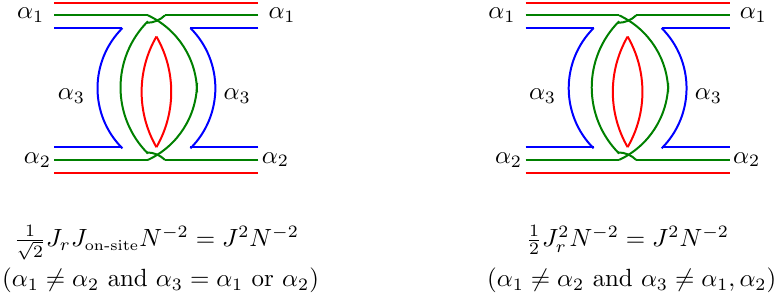
Figure 7. Contribution of interactions to dipoles of red color. For (cid:11) 1 = (cid:11) 3 6 = (cid:11) 2 = (cid:11) 4 , there are two con(cid:12)gurations that can give a contribution to the dipole of red